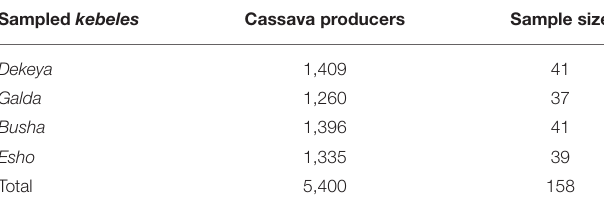
TABLE 1 | Distribution of cassava producer households in Kebeles, Offa